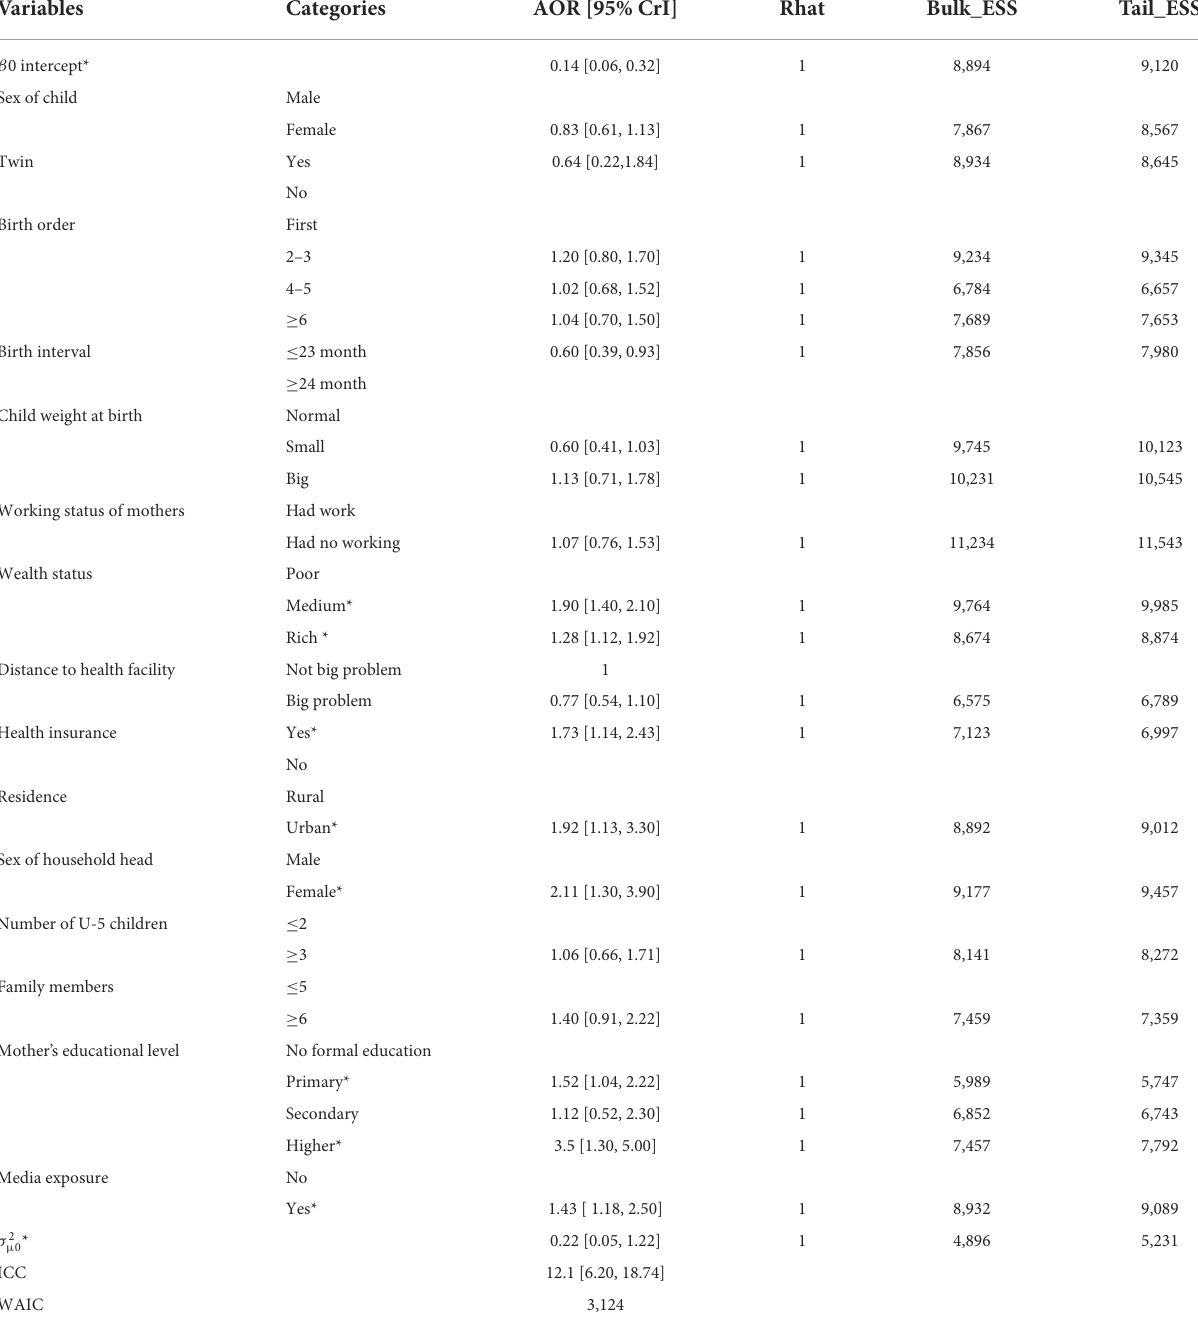
TABLE 3 Factors associated with ORS utilization among under-five children in diarrhea hotspot regions of Ethiopia in 2016.